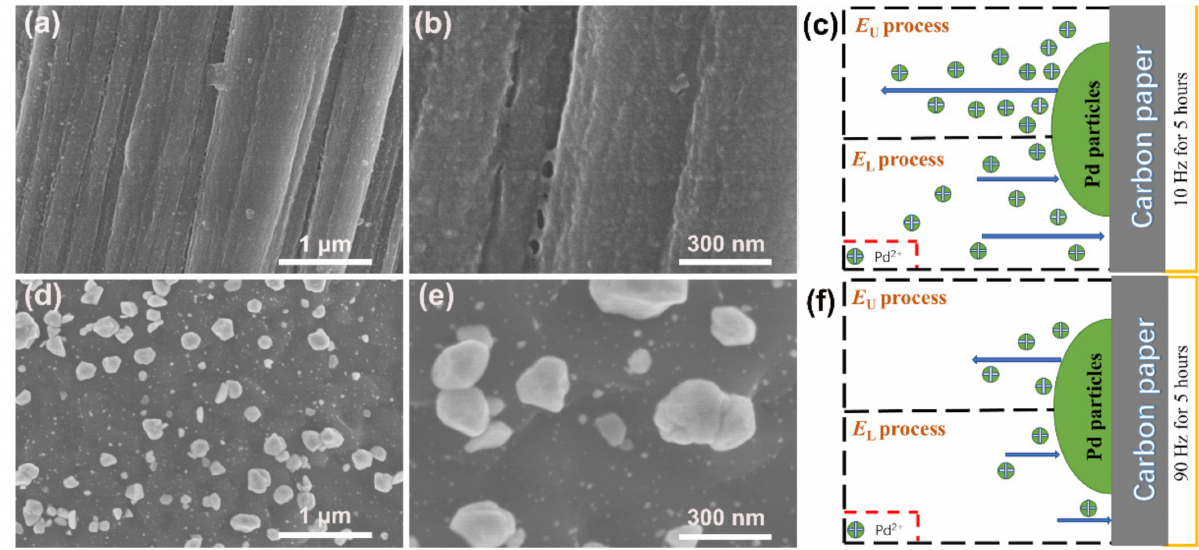
Figure 2. ( a ) Low-magnification SEM image and ( b ) high-magnification SEM image of Pd electrodeposited at − 0.15 mA cm − 2 for 2700 s on carbon paper and then treated by square-wave potential between 0.6 V and − 3.2 V for 5 h with a frequency of 10 Hz in 1 M H 2 SO 4 solution (Pds − 10 Hz); ( c ) the corresponding schematic diagram of Pd 2+ ions movement during a complete E U –E L process at 10 Hz; ( d ) low-magnification SEM image and ( e ) high-magnification SEM image of Pd particles electrodeposited at − 0.15 mA cm − 2 for 2700 s and then modified by square-wave potential between 0.6 V and − 3.2 V for 5 h with a frequency of 90 Hz in 1 M H 2 SO 4 solution (Pds − 90 Hz); and ( f ) the corresponding schematic diagram of Pd 2+ ions movement during a complete E U –E L process at 90 Hz.